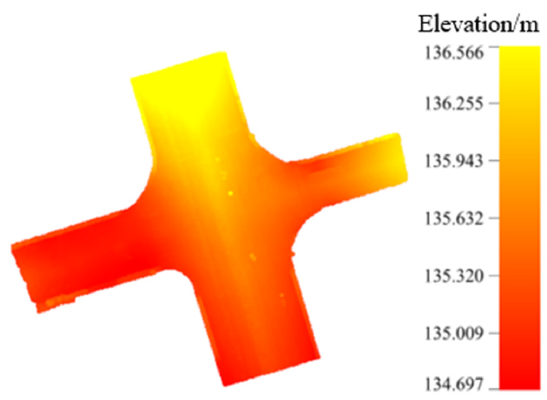
Figure 8. Generated point set.